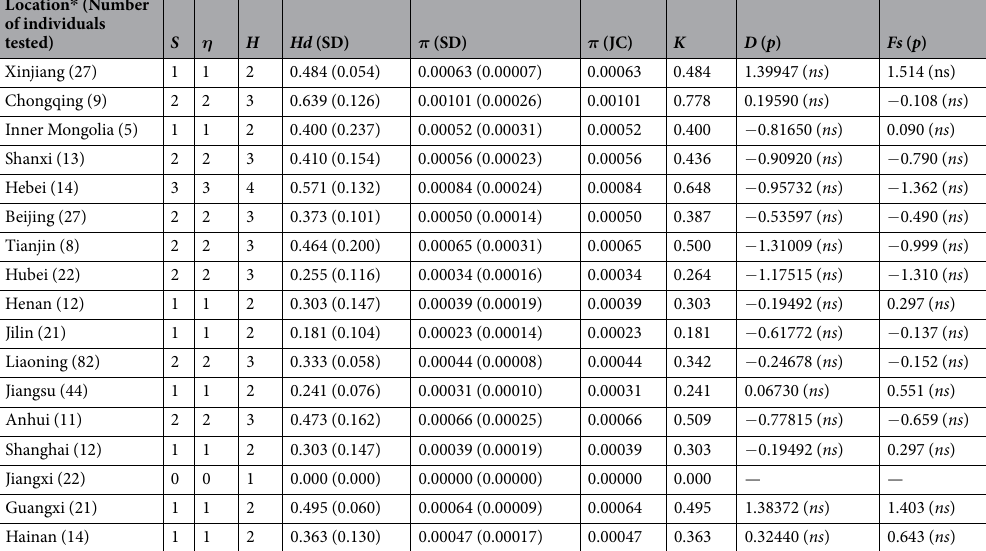
Table 2. Genetic diversity indices of Bemisia tabaci Q collections in China in 2011 based on 773-bp mtCOI fragment. * The indices for the Shannxi, Hunan and Zhejiang samples were not calculated because the numbers of individuals were below 5; S , number of polymorphic (segregating) sites; η , total number of mutations; H , number of haplotypes; Hd , haplotype diversity; π , nucleotide diversity; K , average number of nucleotide differences; π (JC), nucleotide diversity with Jukes and Cantor correction; D , Tajima’s D statistic; Fs , Fu’s F test statistic; ns, not significant.